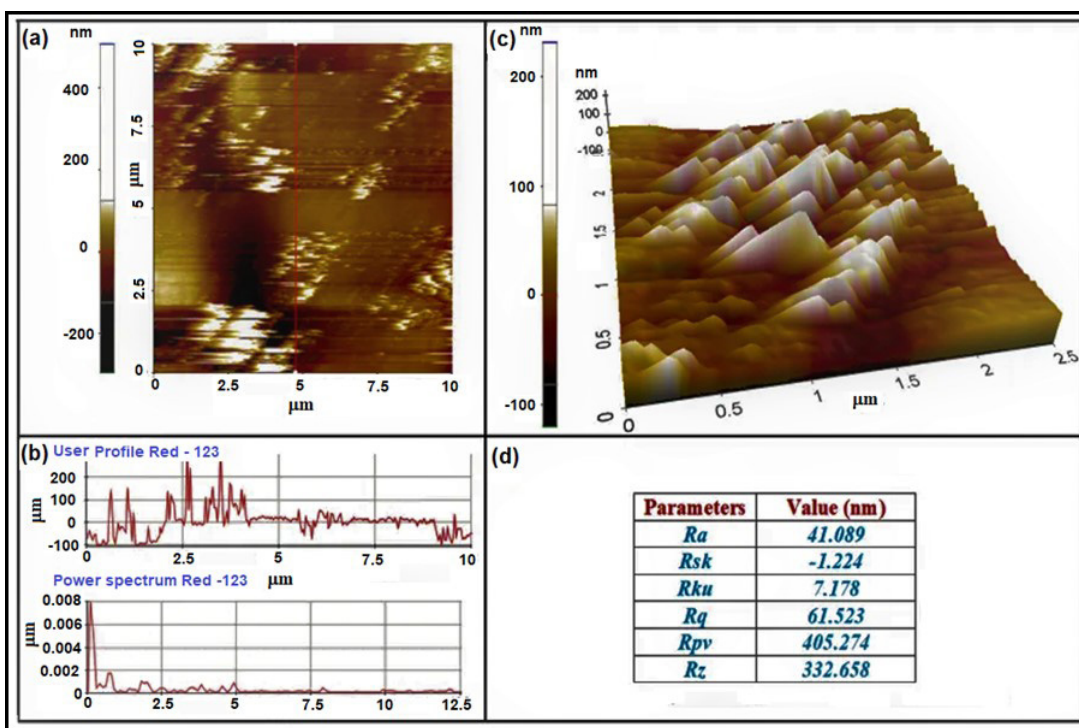
Figure 14. (a) Roughness Surface Texture, (b) 2-D Line Diagram for Roughness measurement of NF, (c) 3-D Roughness Surface Texture, and (d) Roughness Parameters.